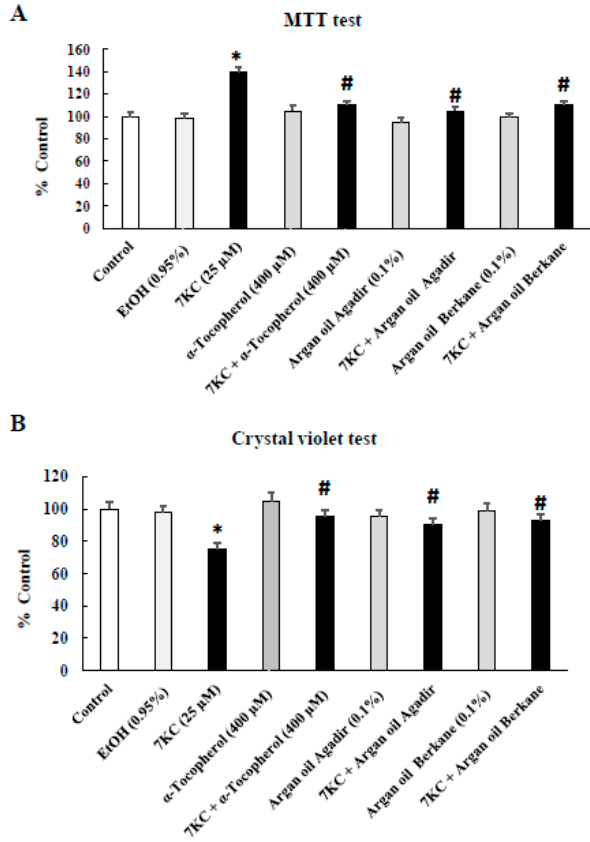
Figure 1. Evaluation of the effect of argan oil on 7-ketocholesterol (7KC)-induced cell growth inhibition in 158N murine oligodendrocytes with the crystal violet and MTT tests. After 24 h of culture, 158N murine oligodendrocytes were cultured for an additional 24 h without or with 7KC (25 µM) in the absence or presence of argan oils (Agadir or Berkane; Morocco; 0.1% v / v ) or α -tocopherol (400 µM) used as the positive control. Argan oils and α -tocopherol were added to the culture medium 2 h before 7KC. The cytoprotective effect of argan oils on 7KC-induced inhibition of cell growth was evaluated with the crystal violet test (measurement of adherent cells) ( A ) or the MTT test (measurement of the activity of the succinate deshydrogenase, a mitochondrial enzyme belonging to the Krebs cycle) ( B ). The experiments were carried out three times in triplicate. Data are mean ± standard deviation (SD) of two independent experiments carried out in triplicate. The significance of the relationship between vehicle and cells treated with 7KC, argan oils or α -tocopherol was calculated by the Anova test (Sidak’s multiple comparisons); * p ≤ 0.05. The significance of the relationship between cells treated with 7KC alone, 7KC and argan oils cotreatment, or 7KC and α -tocopherol cotreatment was calculated by the Anova test (Sidak’s multiple comparisons); # p ≤ 0.05. No significant difference was found between control and vehicle-treated cells (EtOH 0.95% v / v ). The EtOH value of 0.95% corresponds to the highest EtOH concentration obtained when the cells were simultaneously treated with 7KC used at 25 µM (EtOH, 0.05%) and with argan oil (EtOH, 0.9% v / v